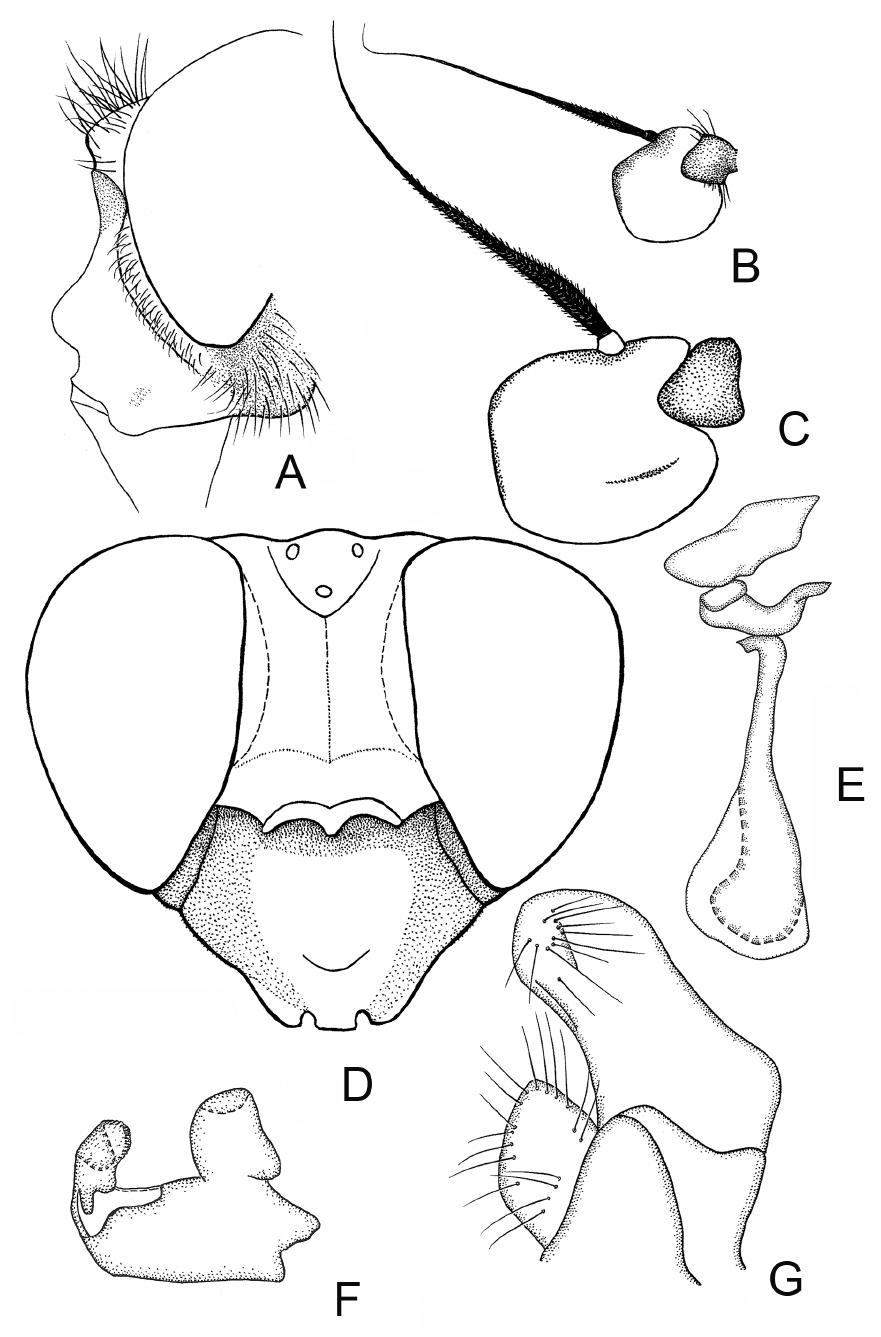
Figure 8. Cheilosia hercyniae Loew. A Male head, lateral view B Antenna of male, lateral view C An- tenna of female, lateral view D Head of female, dorsal view E–G male genitalia, lateral, from left to right: E Aedeagal complex F Superior lobe G